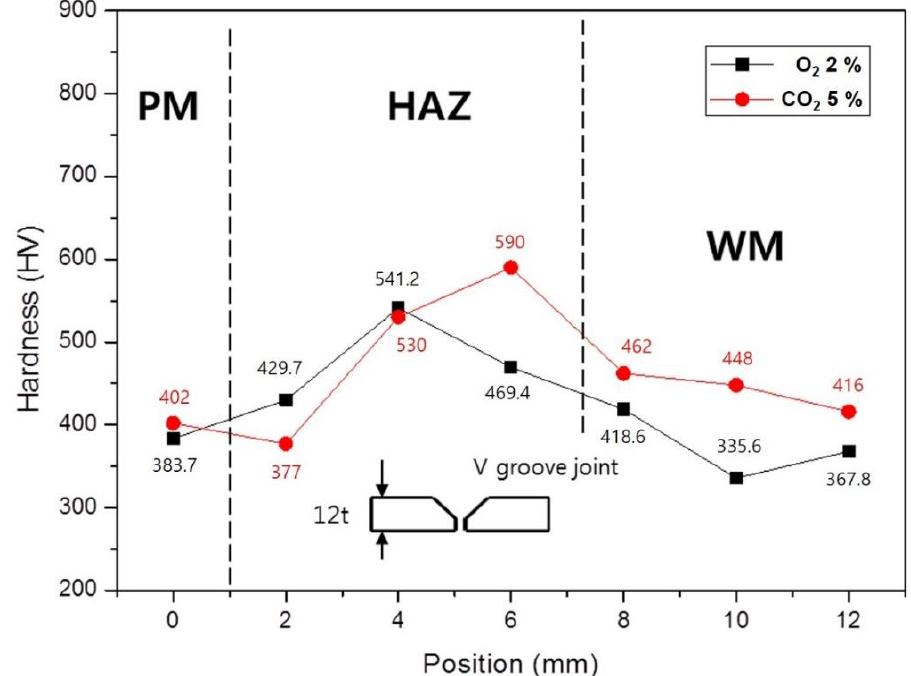
Figure 2. Hardness test results in butt joint with variation of shielding gas: ( a ) O 2 2%, 14.0~15.5